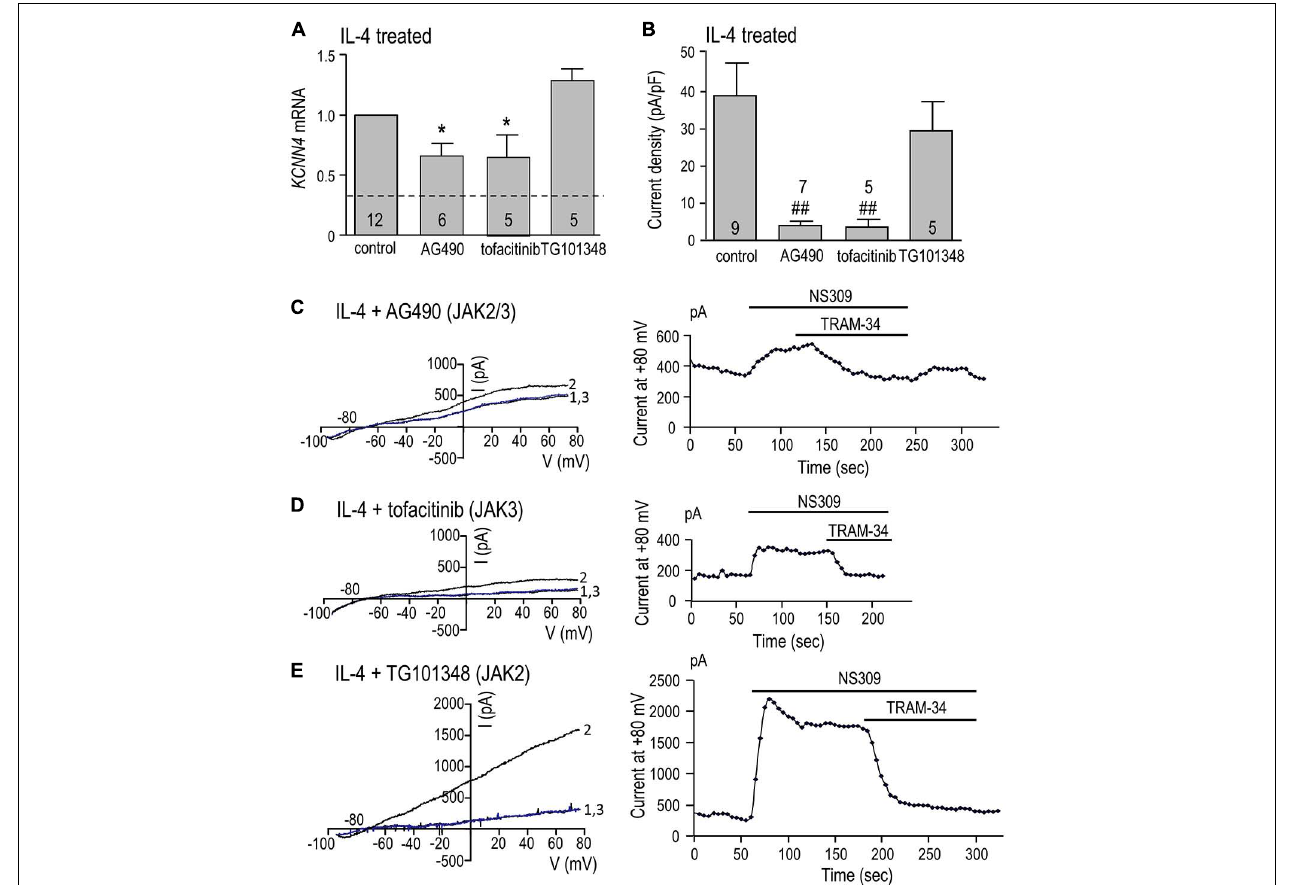
FIGURE 5 | JAK3 is required for induction of KCNN4 mRNA and KCa3.1 current in IL-4 treated microglia. Rat microglia were treated for 24 h with 20 ng/ml rat recombinant IL-4 without (control) or with a JAK inhibitor: 10 μ M AG490 (for JAK2/3), 10 nM tofacitinib (for JAK3), or 30 nMTG101348 (for JAK2). (A) IL-4-mediated induction of KCNN4 mRNA was examined using quantitative real-time qRT-PCR. Control KCNN4 mRNA levels in unstimulated microglia (no IL-4) are indicated by the dashed line. KCNN4 levels were normalized to IL-4-treated cells (set to 1.0) and compared with and without each inhibitor. (B) Summary ofTRAM-34-sensitive KCa3.1 current densities (pA/pF). NS309-evoked currents were measured at + 80 mV in IL-4-treated